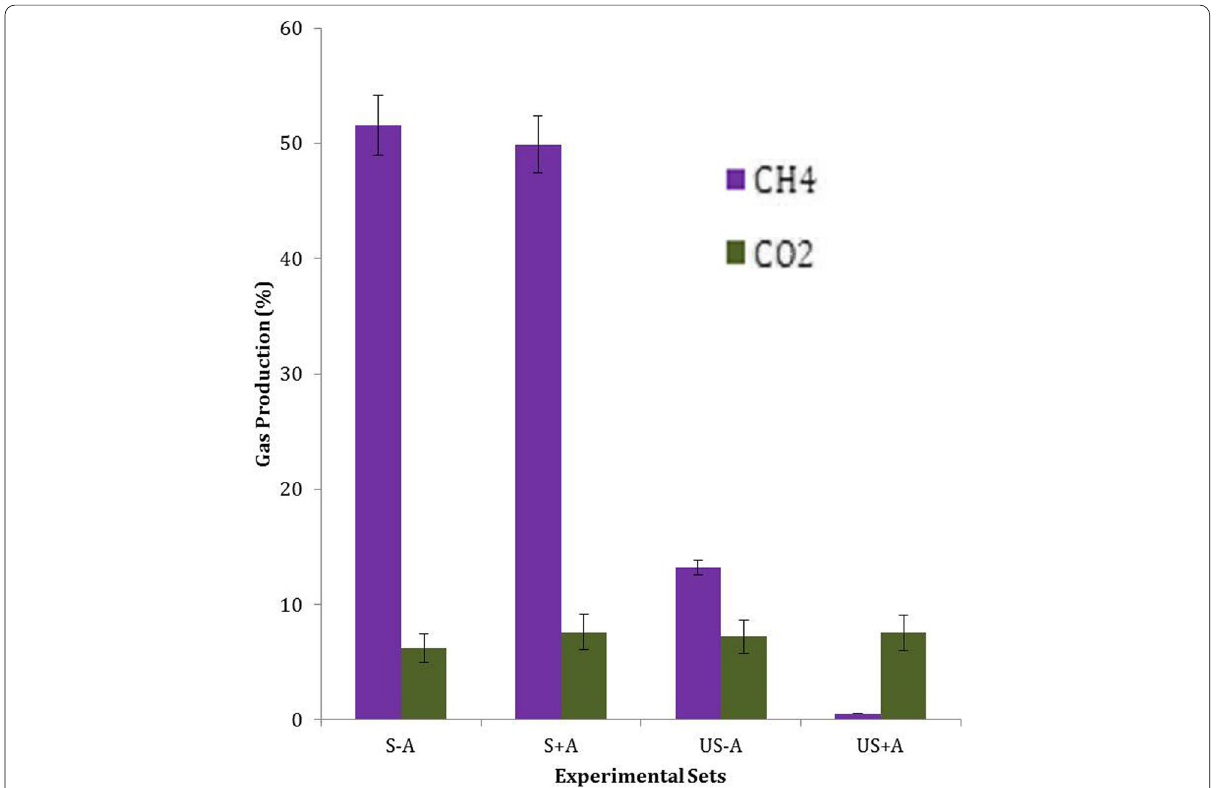
Fig. 9 The compatibility test in modified media with waste coal and tube well water (Set 1: S-A, where S signifies nitrogen sparge media (anaerobic) and -A represents without autoclave media; Set 2: S A, where S signifies nitrogen sparge media and + Set 3: US-A, where US signifies without sparging media (aerobic) and -A represents without autoclave media; Set 3: US without sparging media (aerobic) and A represents autoclave +